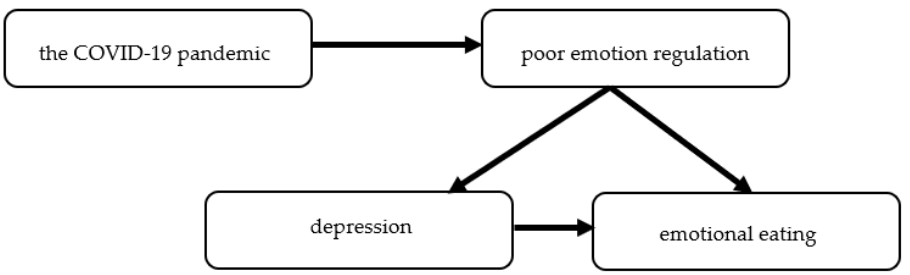
Figure 7. The impact of the COVID-19 pandemic on emotional eating.